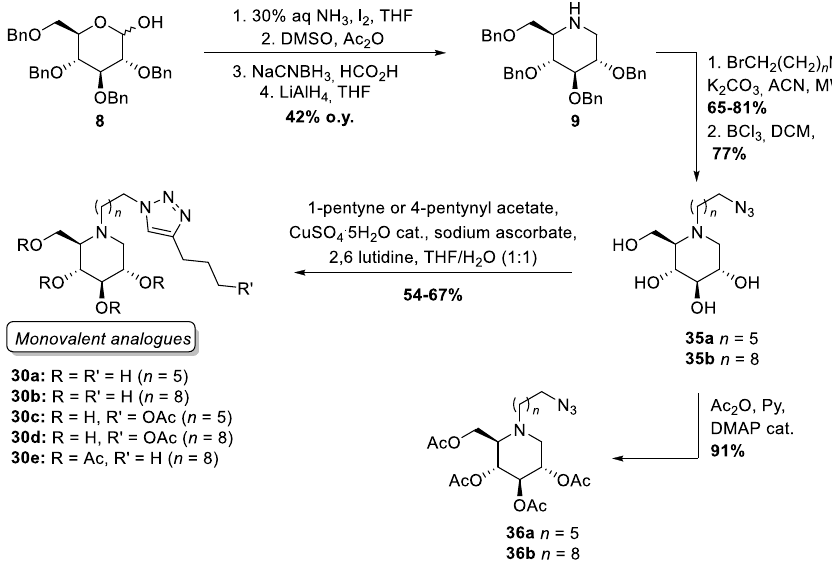
Figure 8. Multivalent iminosugars as F508del-CFTR